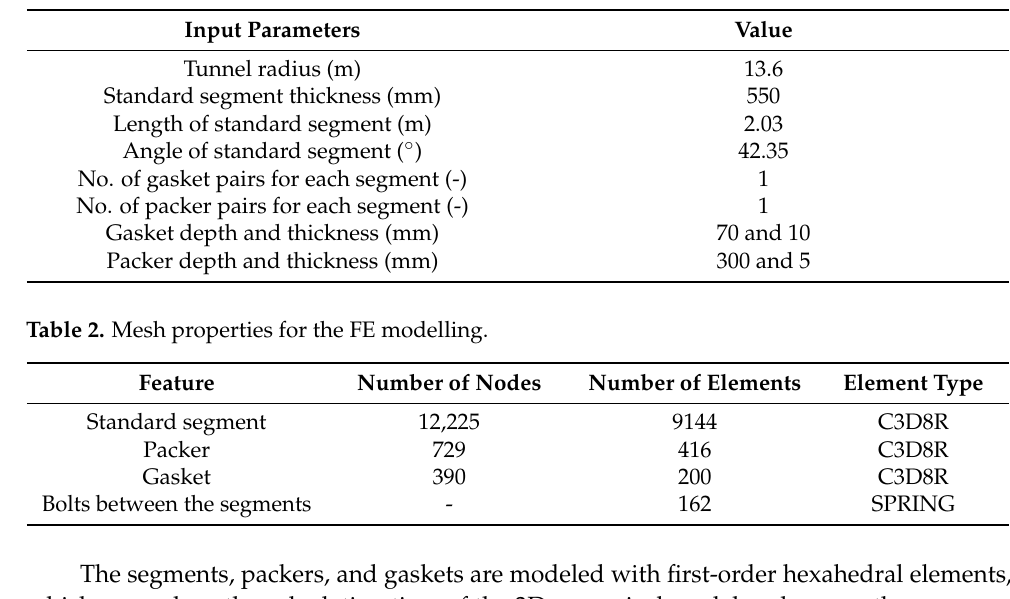
Figure 4. Geometry and mesh of finite element models: ( a ) The location of the butyronitrile cork packer and elastic gasket; ( b ) Position of longitudinal loads acting; ( c ) Mesh of standard segments; ( d ) Description of segment orientation. Table 1. Input geometrical parameters for the finite element models.